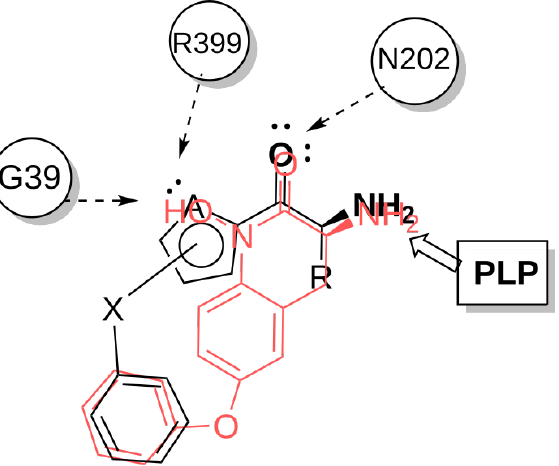
Figure 4. Heterocyclic α -amino ketones as a promising inhibitor class, showing the main interac- tions, from left to right: aromatic heteroatom accepting a H-bond from G39 or R399; ketone accept- ing a H- bond from N202; α -amino group in the vicinity of the PLP cofactor.